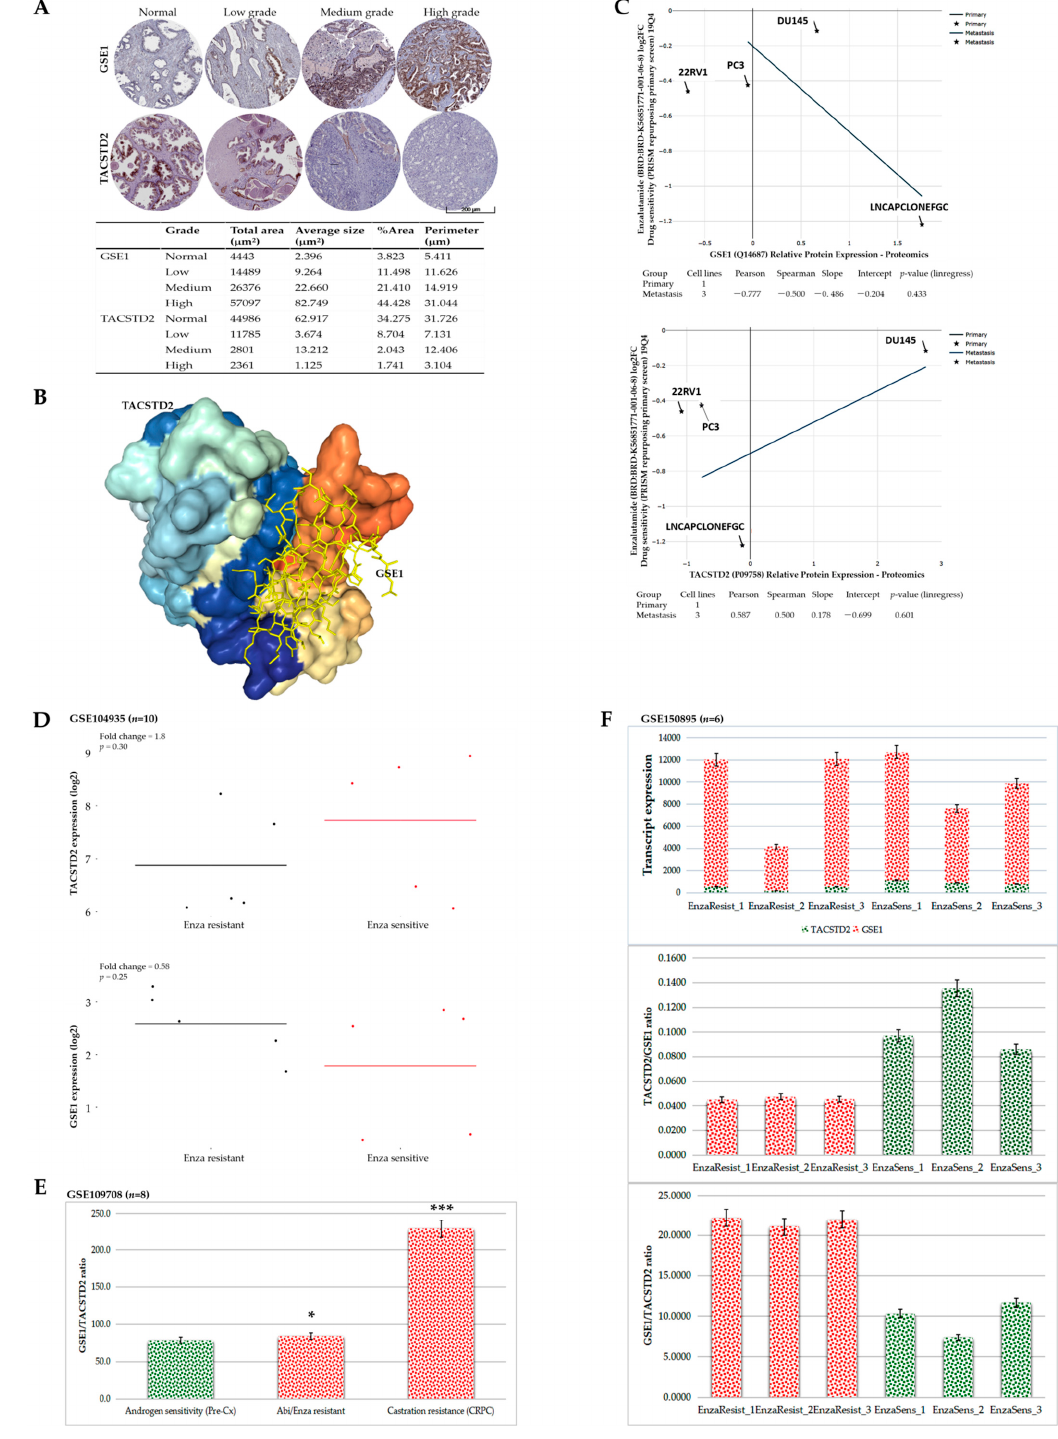
Figure 6. GSE1 and TACSTD2 interaction or expression profiles reflect abiraterone/enzalutamide drug resistance, androgen sensitivity, and castration resistance in patients with prostate cancer. ( A ) Representative IHC staining photomicrographs ( top ) and quantitative chart ( bottom ) of the differential expression of GSE1 or TACSTD2 protein in normal, low-grade, medium-grade, and high-grade PCa samples from the TMU-SHH cohort. ( B ) Molecular docking showing the direct interaction between TACSTD2 and GSE1. ( C ) Graphical representations of the association between GSE1 ( top ) or